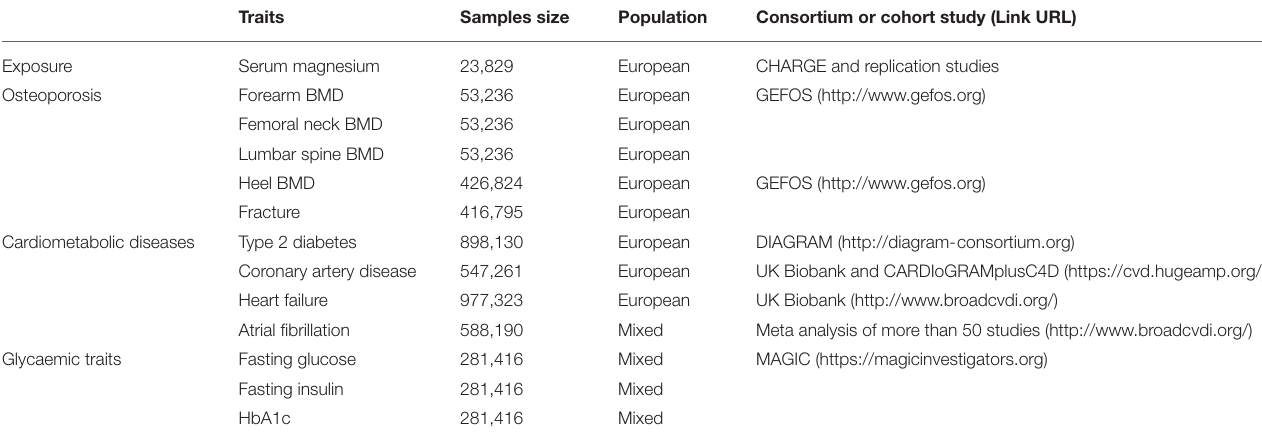
( Supplementary Figure 3D ). This primary (IVW) analysis found no obvious causal influence of serum magnesium on